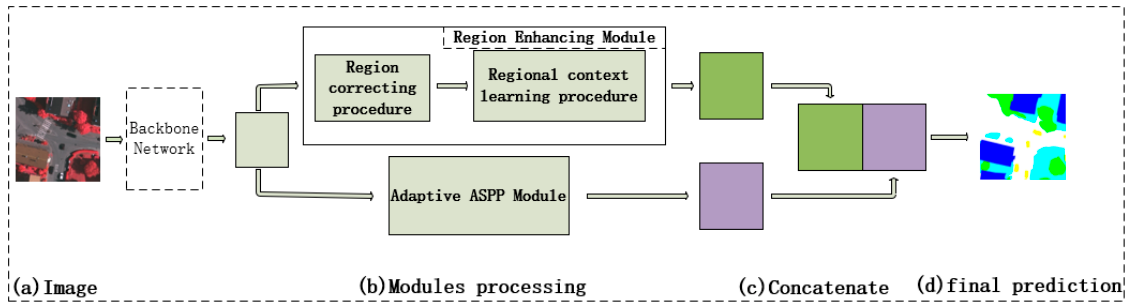
Figure 1. The proposed architecture of region-enhancing network (RE-Net). The upper branch is the region enhancing module, and the lower branch is the adaptive ASPP module. ( a ) the original image; ( b ) the modules processing process; ( c ) concatenate two features from corresponding module. ( d ) the final prediction of our work.